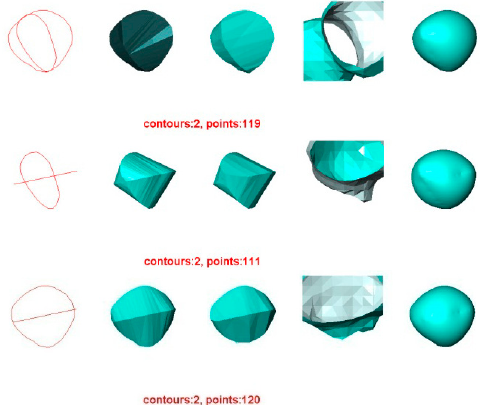
Figure 9. Surface reconstruction of another human liver tumor by four methods. For each row, from left to right: the contours used, the surface reconstructed by BPA, the surface reconstructed by Power Crust, the surface reconstructed by Poisson, and the surface reconstructed by VSR.